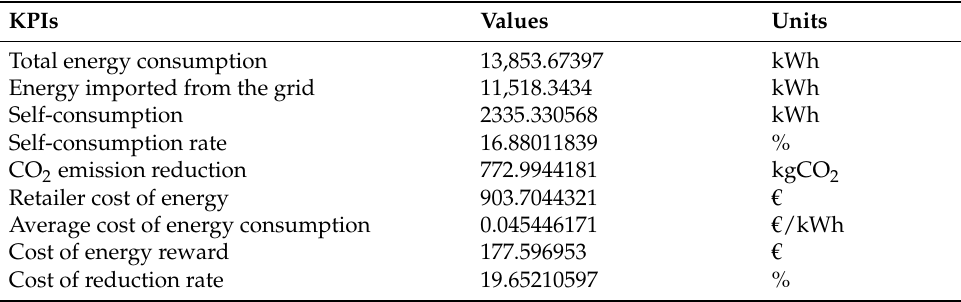
Table 4. Summary of the